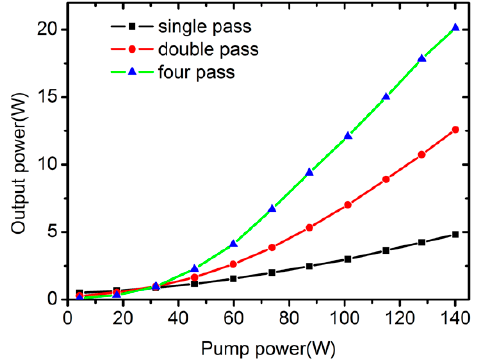
Figure 9. Amplification performance of single-, double-, and four-pass amplification versus the pump power.